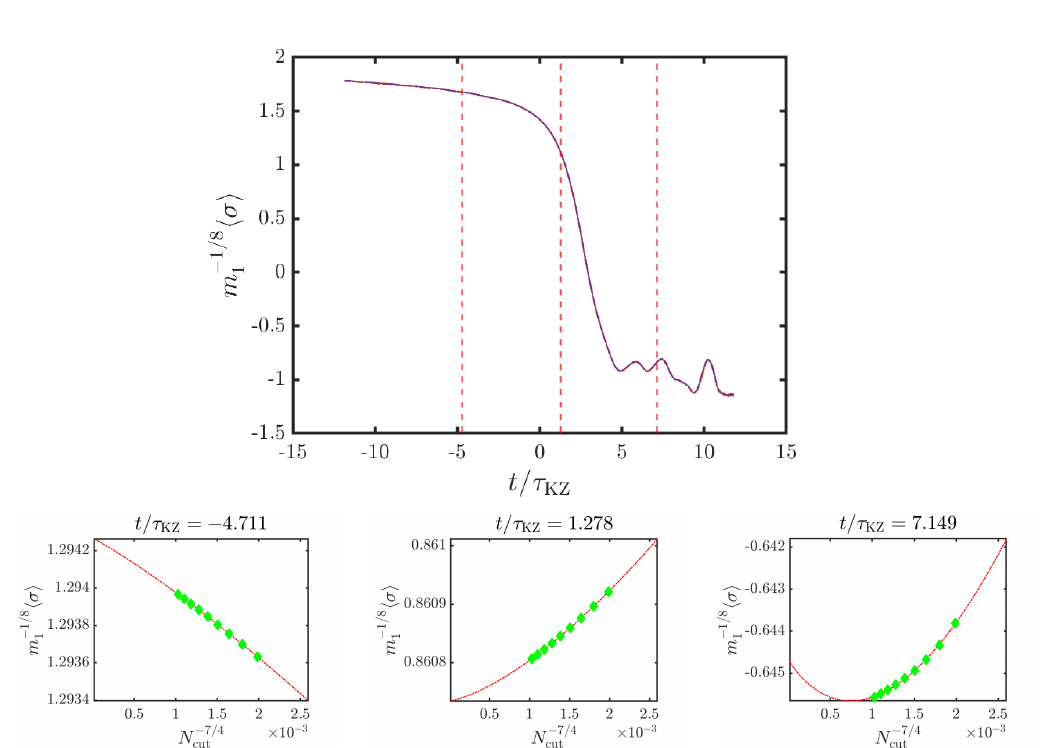
Figure C.2: Details of the extrapolation for the dynamical one-point function of the magnetisation ramp along the E and range of cut-offs is the same as in Fig. C.1. Note the range of the y axis in the